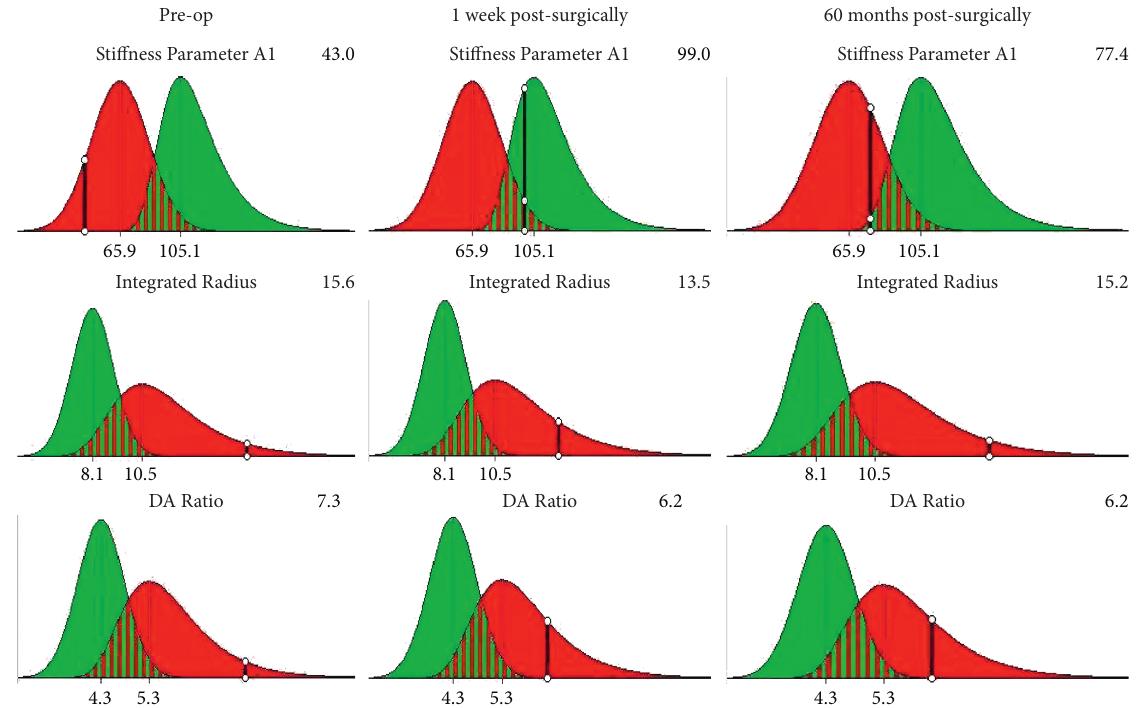
Figure 4: Stiffness parameter at applanation 1 (SP-A1) of the cornea significantly increased from 42.73 ± 8.93mmHg/mm to 80.08 ± 8.94mmHg/mm within 1 week postsurgically and remained stable over the following 5 years. Deformation amplitude ratio (DA ratio) did not change significantly from those of the preoperative period ( P